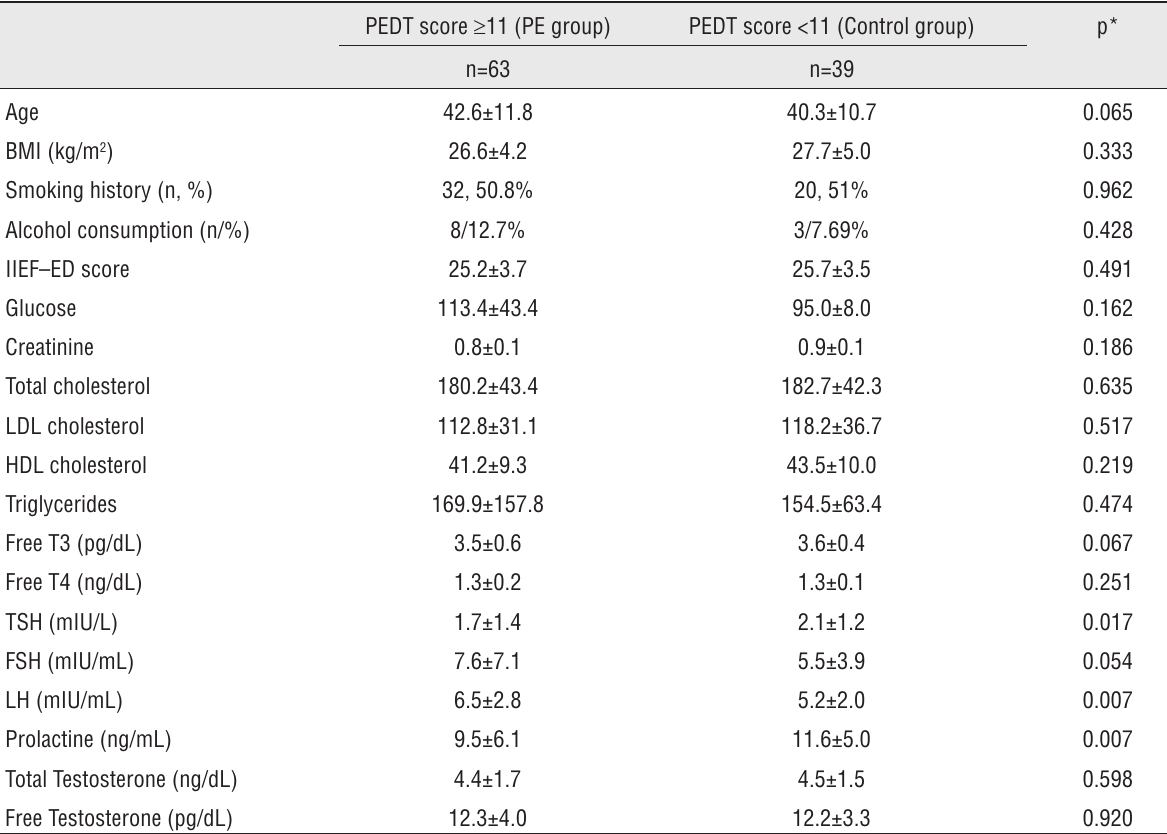
Table 1 - Characteristics and hormonal status of the studied